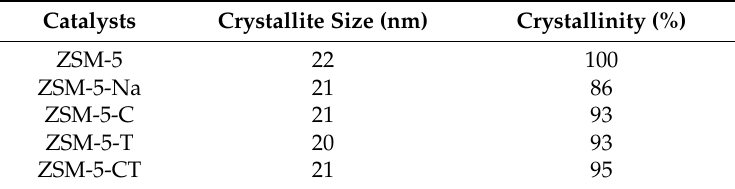
Figure 2. FT ‐ IR spectra for untreated and treated zeolite catalysts before ( a ) and after ion exchange ( b ). Where ZSM ‐ 5 is in black, ZSM ‐ 5 ‐ Na is in red, ZSM ‐ 5 ‐ C is in green, ZSM ‐ 5 ‐ T is in blue, and ZSM ‐ 5 ‐ CT is in purple.